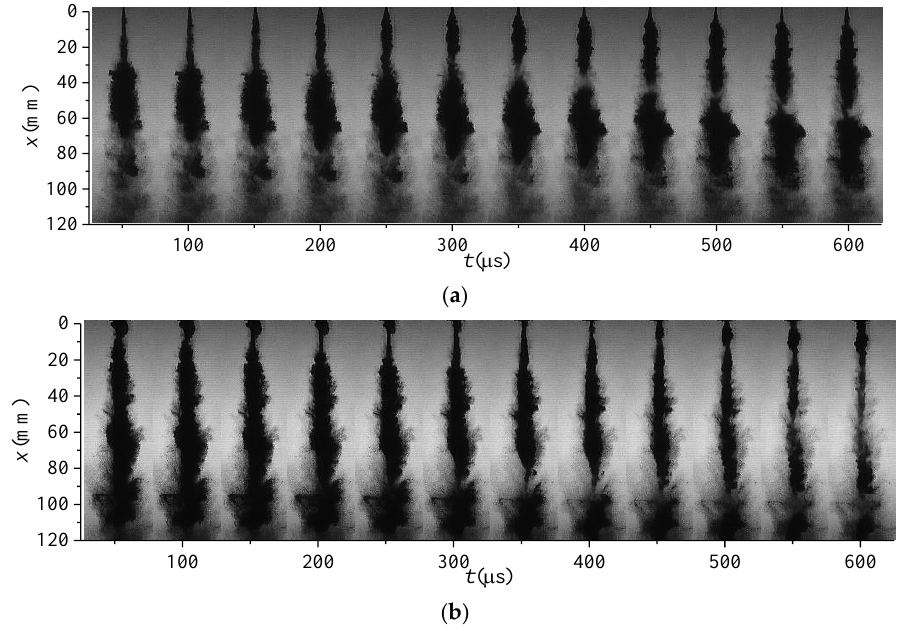
Figure 8. Cavitation cloud morphology of two nozzles. ( a ) Organ pipe nozzle without whistle. ( b ) Organ pipe nozzle with divergent whistle.